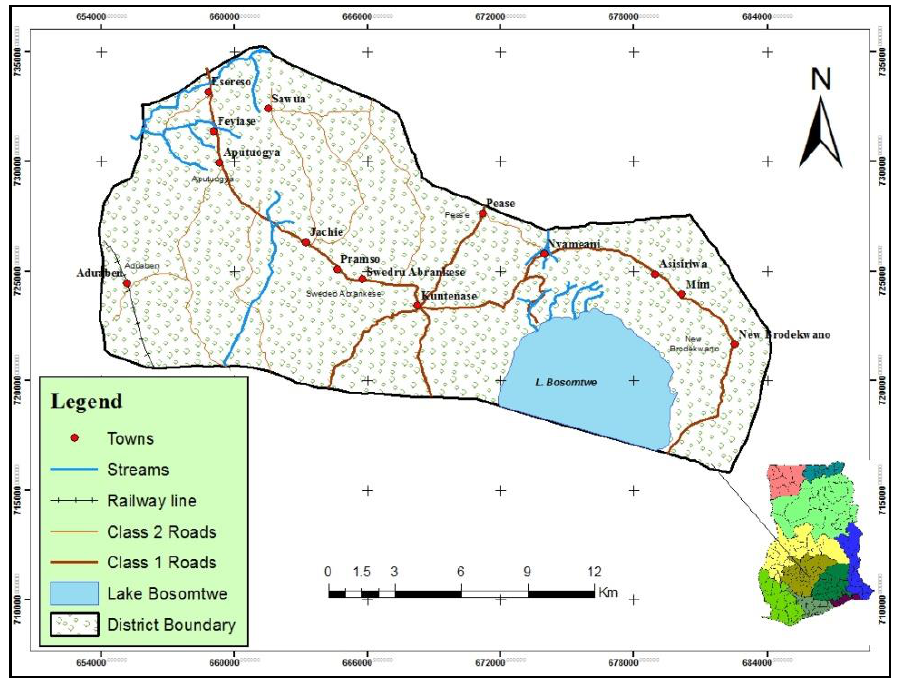
Figure 6. Map of the Bosomtwe District showing the study communities in